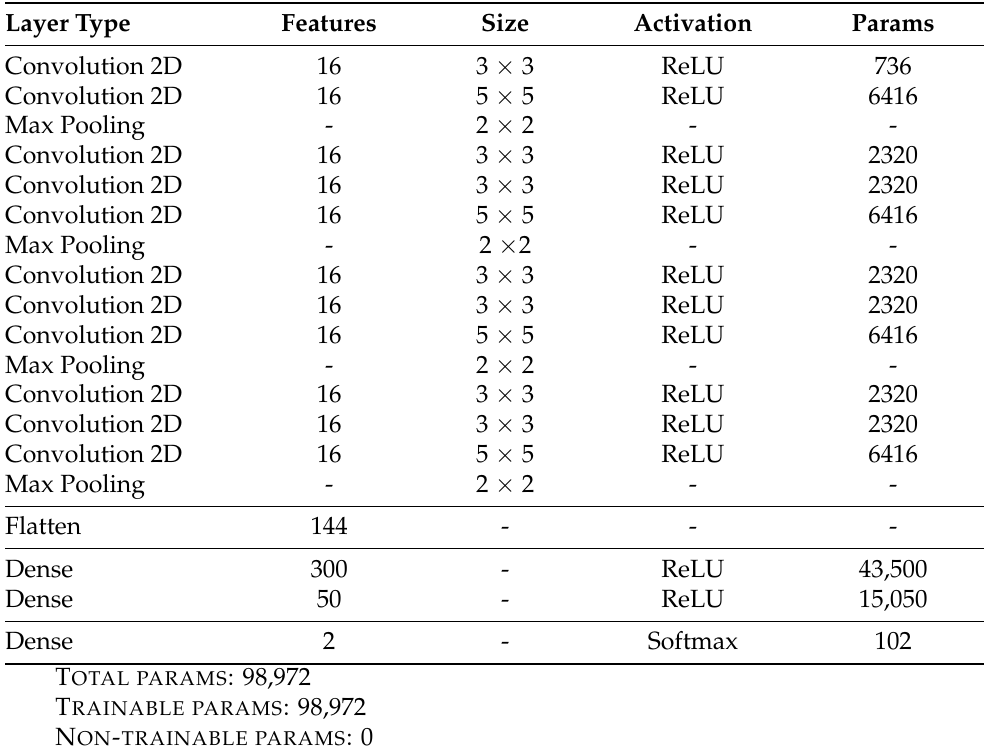
Table 10. Layer-by-layer summary of the proposed smaller-scale CNN model. Each layer name is given followed by the number of feature maps (convolutional layers) or neurons (dense layers), the size of the convolutional filter or pooling region, the activation function used and, last, the number of parameters to learn.